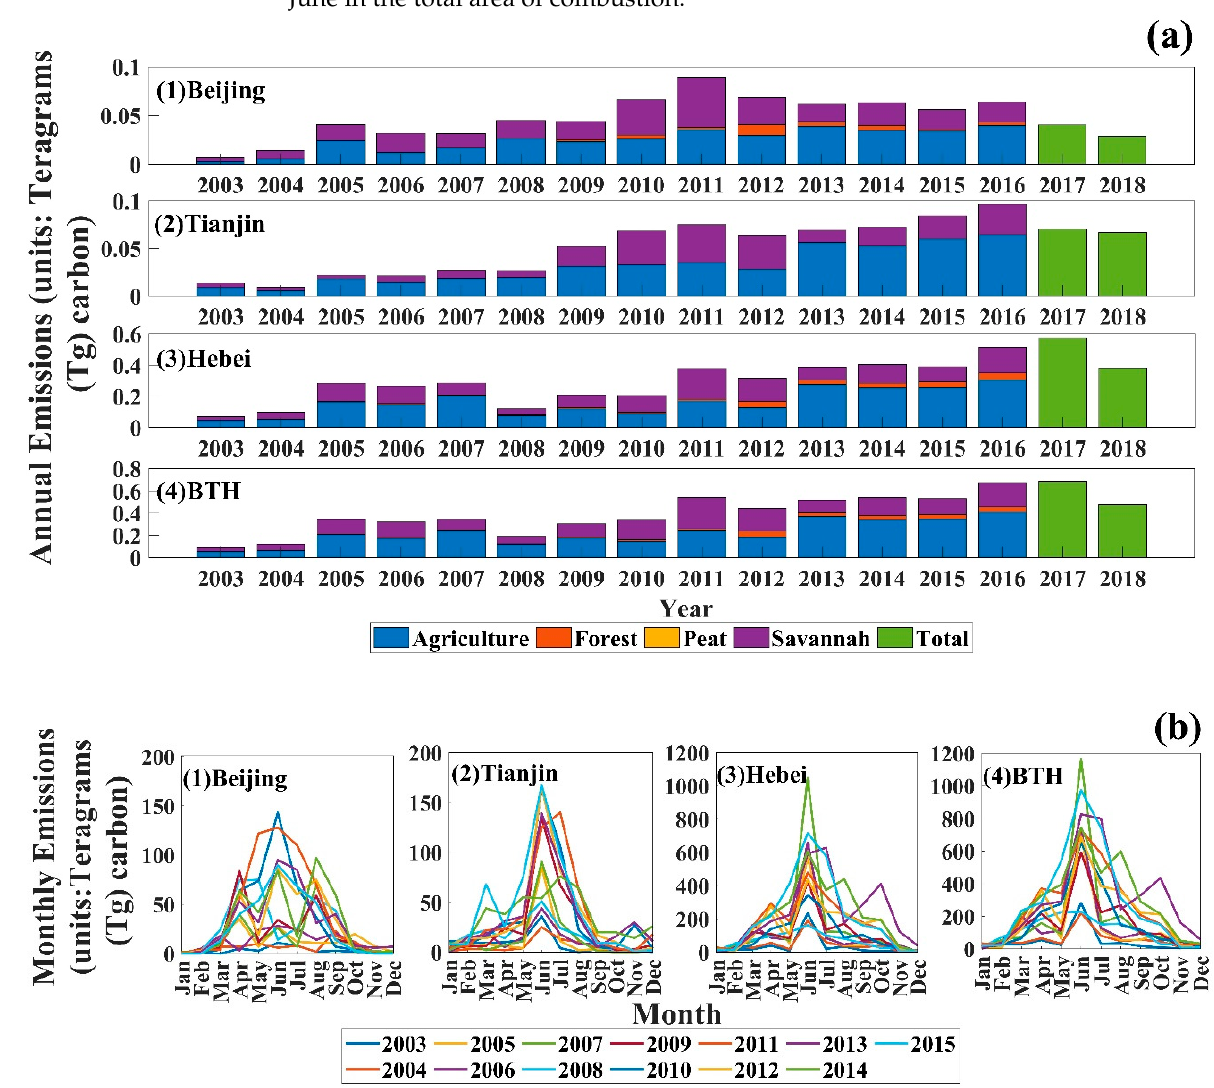
Figure 5. ( a ) The annual variation of BB carbon emission from GFED4 in BTH from 2003–2018; ( b ) monthly BB carbon emission from GFED4 in BTH from 2003–2015. In addition, the annual data